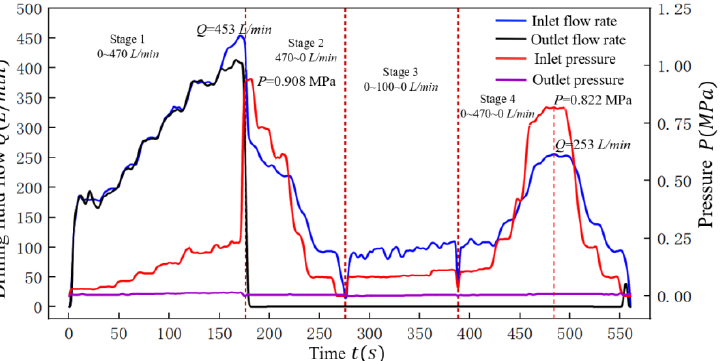
Figure 16. Drilling fluid flow and pressure of Experiment II and Experiment III changed with time.